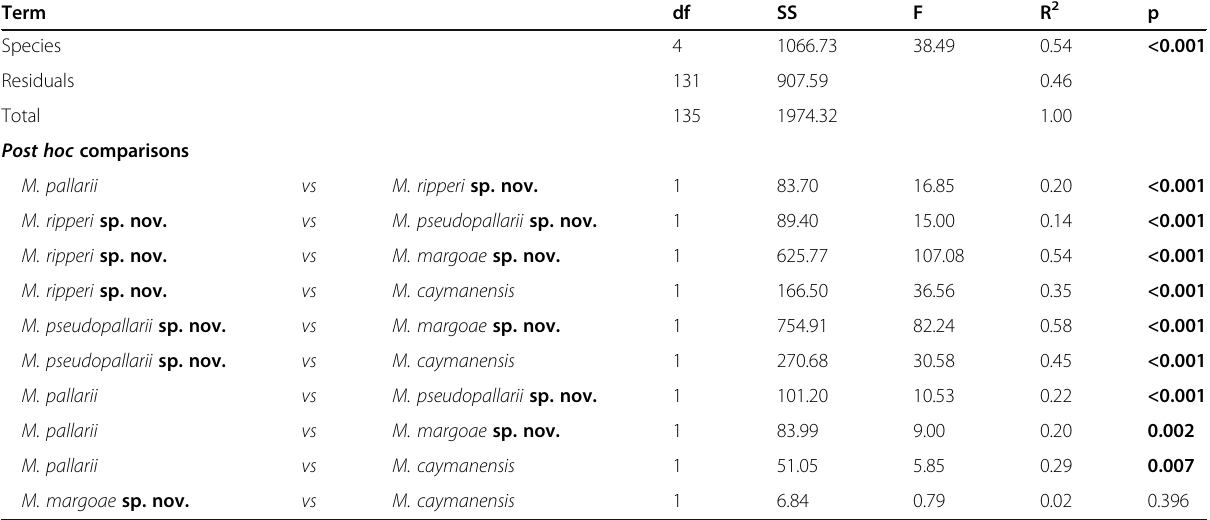
Table 4 Results of PERMANOVA and post hoc pairwise PERMANOVA comparisons for the first two principal components (PCs) of animal pt values; significant post hoc p-values at the α -level of p<0.045 (i.e., adjusted with the Benjamini-Hochberg correction) are in bold Term df SS F R 2 Species